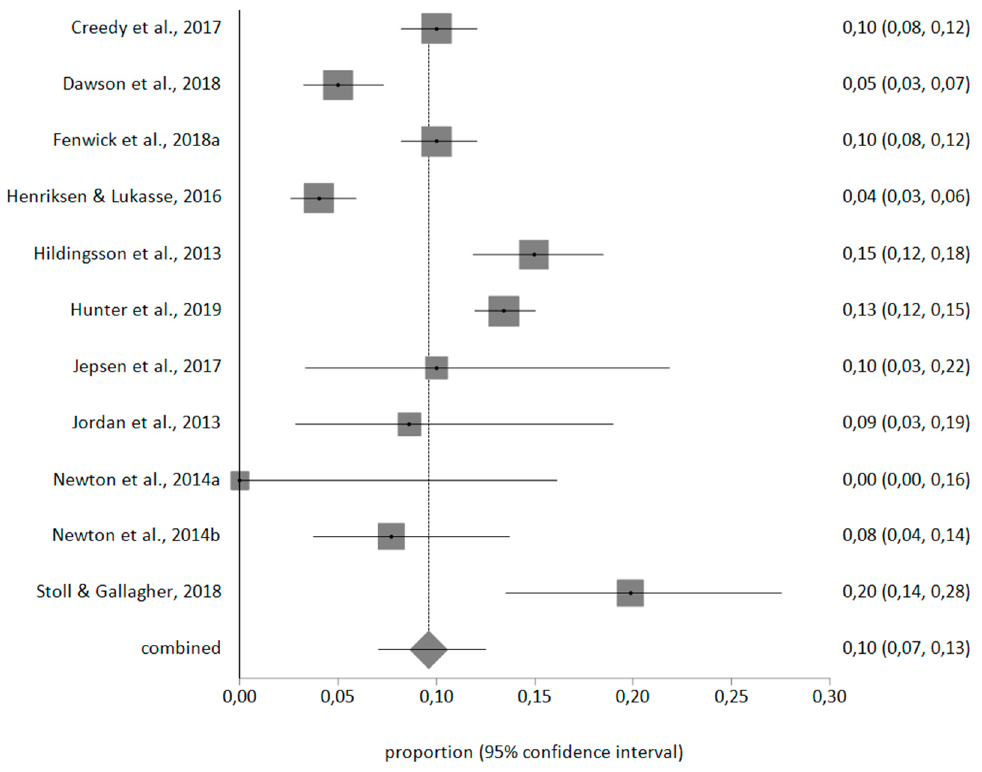
Figure 4. Forest plot of client-related burnout prevalence.